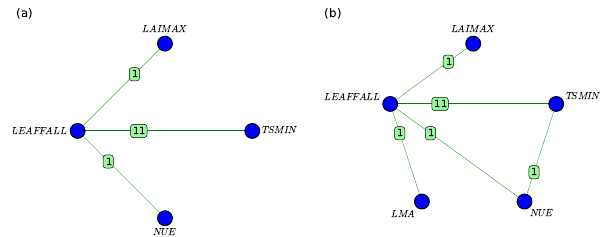
Figure 8. Relevant joint Sobol indices, S ij , corresponding to Octo- ber GPP averages for (a) D ST and (b) D TR . The labels on each line show the magnitude, in %, of Sobol indices for the corresponding parameter pairs.